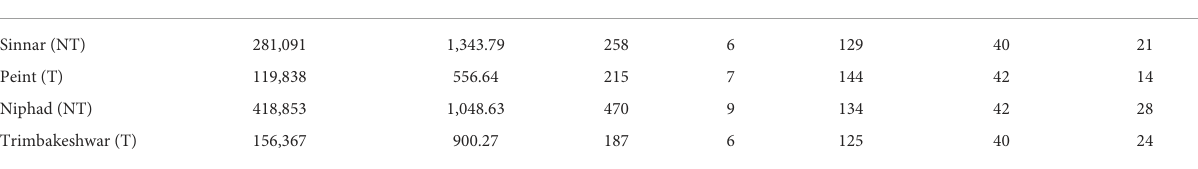
TABLE 1 Demographic information of study area, Nashik as per Census 2011, India.